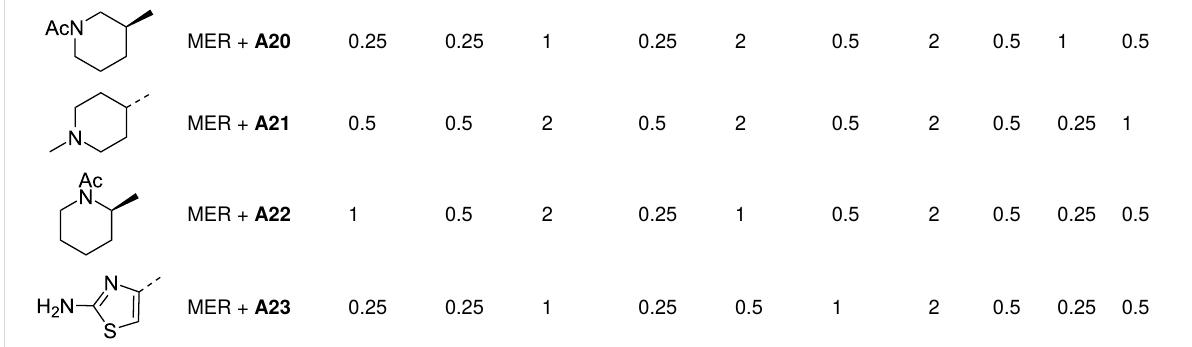
Table 1: In vitro antibacterial activity of avibactam and compounds A1-23 alone as well as in combination with meropenem (MER).